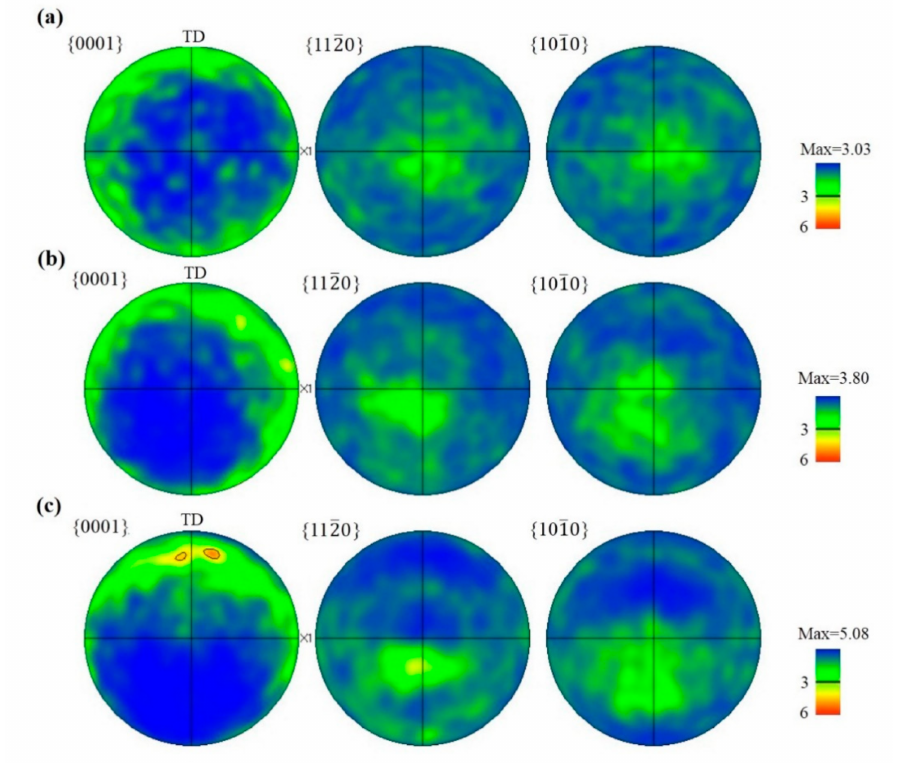
(cid:0) (cid:1) (cid:0) (cid:1) 1010 , and 1011 planes of the twisted samples